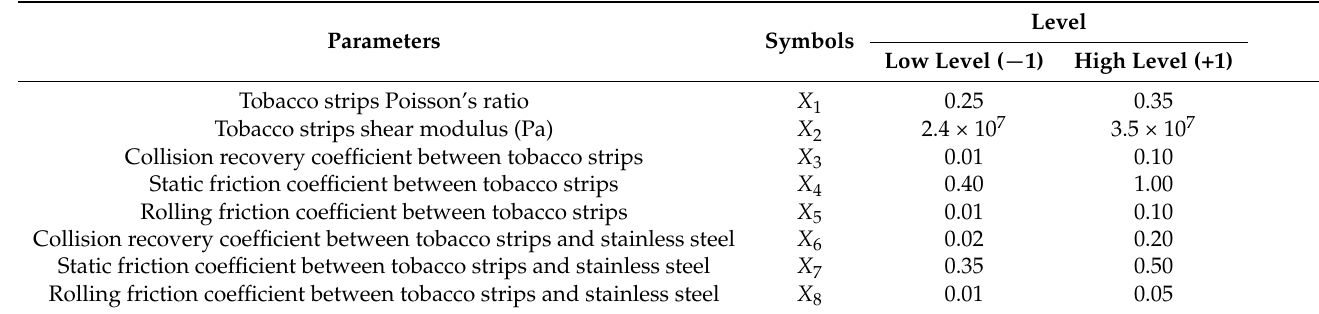
Table 4. Plackett–Burman test parameters.